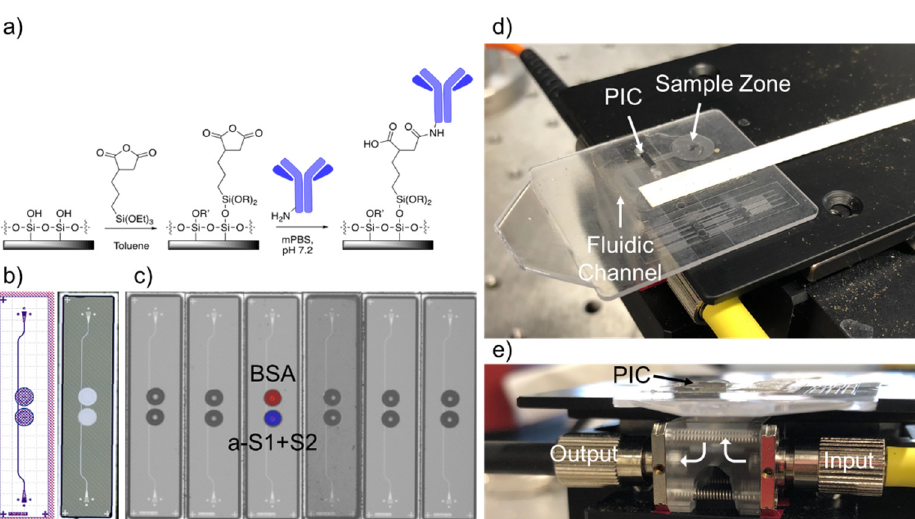
Figure 1. Disposable Photonic Assay Platform. ( a ) Functionalization schematic. The silicon dioxide surface of the chip is functionalized with 3-(triethoxysilyl)propyl succinic anhydride in anhydrous toluene, which then forms an amide bond with free amine groups of antibodies in solution. Here R = H or OEt; R’ = H or 3-succidimidylpropyl trialkoxysilane, as the density is unknown. ( b ) GDS (Graphic Design System) and laser confocal image of the 1 × 4 mm photonic chips used for this study. Two photonic ring resonators are coupled to a single bus waveguide. The trench etched from the oxide cladding around each ring is visible in white on the right. Light is coupled into and out of the PICs via grating couplers, seen centered at the top and bottom of each chip. ( c ) Image of antibody/antigen solutions spotted on chips with a Scienion SX microarrayer. Spots are approximately 300 nL each and are highly reproducible chip-to-chip. The top ring is spotted with 0.1% BSA solution (control) and the bottom ring with 650 μ g/mL anti-S1+S2 polyclonal antibody solution. ( d ) Image of the full microfluidic/photonic chip assembly. The sample is pipetted onto the sample zone and wicked through the fluidic channel across the PIC. Whatman paper is situated at the end of the channel for controlled wicking of the full sample volume. ( e ) Side view of the custom optical hub. Infrared light from a tunable laser is coupled vertically into and out of the photonic chip from below. Holes in the disposable micropillar fluidic card allow coupling into the grating couplers of the